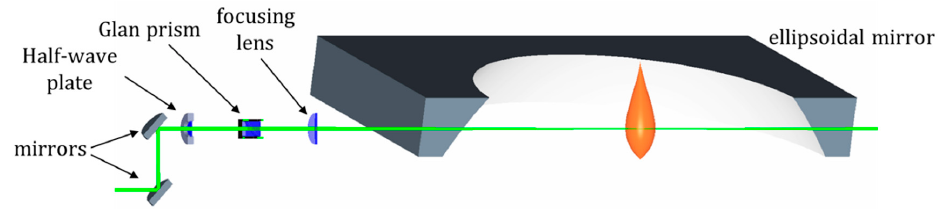
Figure 3. Schematic side-view of the optical set-up for WALS measurements.